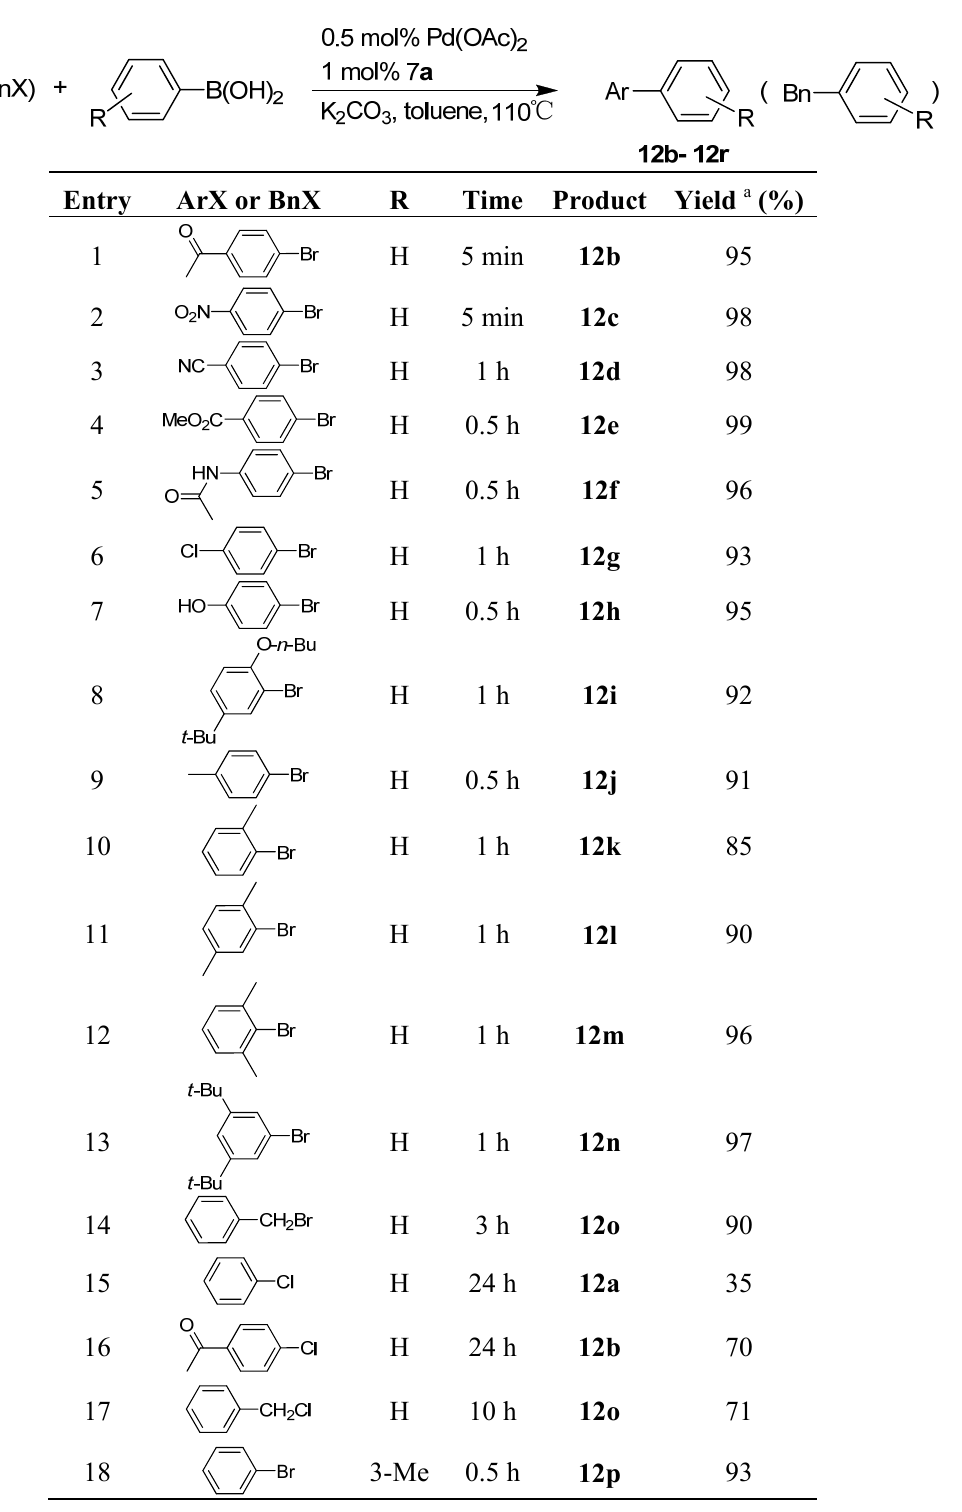
Table 3. Suzuki-Miyaura reaction of aryl halides (benzyl halides) with phenylboronic acid catalyzed by Pd(OAc) / 7a 2